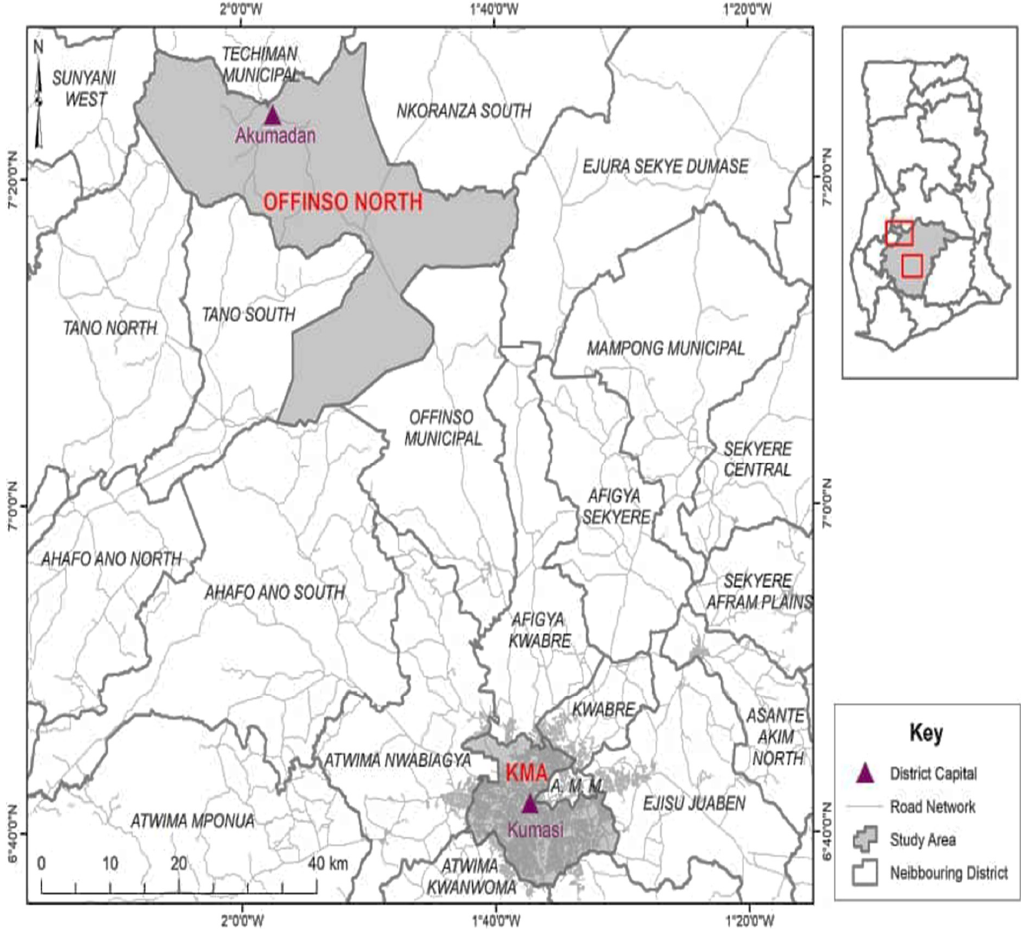
Figure 2. Map of the study area. Source: GIS [32].